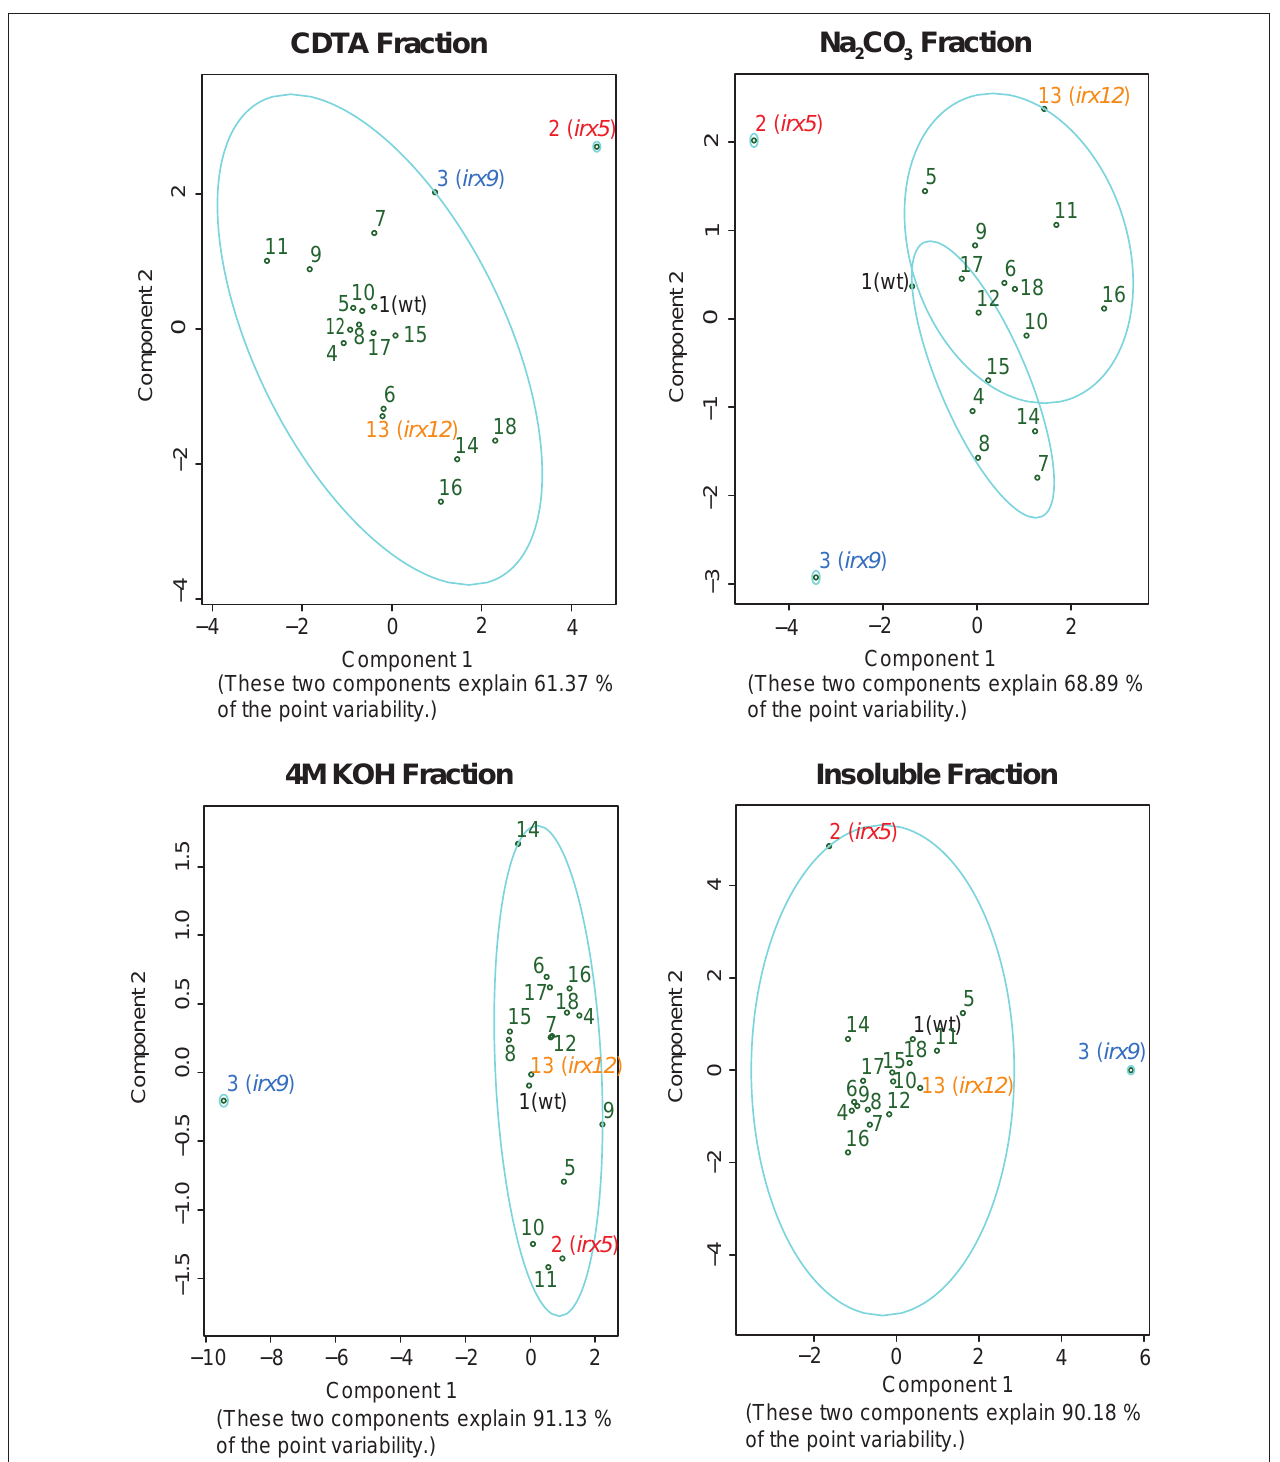
Figure 5 | Principal component analysis and cluster analyses of sugar contents from fractionated cell wall material. Principal component analyses of the mol% sugar values in the different fractions for each mutant. The separation based on the scores from the first two principle components is displayed, and the explained variation of these components is indicated below each graph. The loadings for the variables are included in supplementary